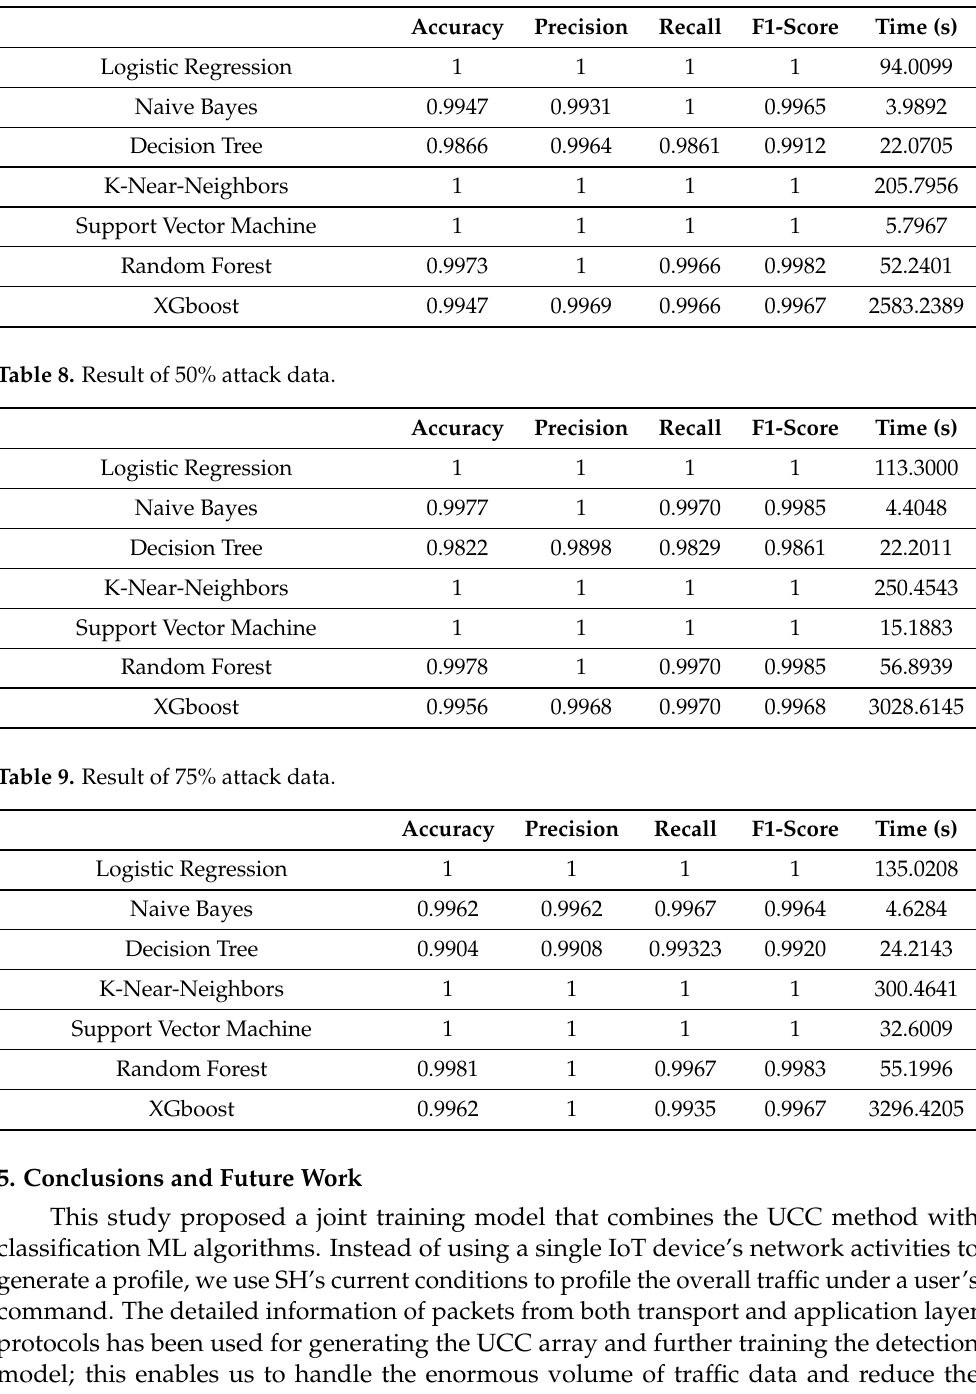
Table 7. Result of 25% attack data.